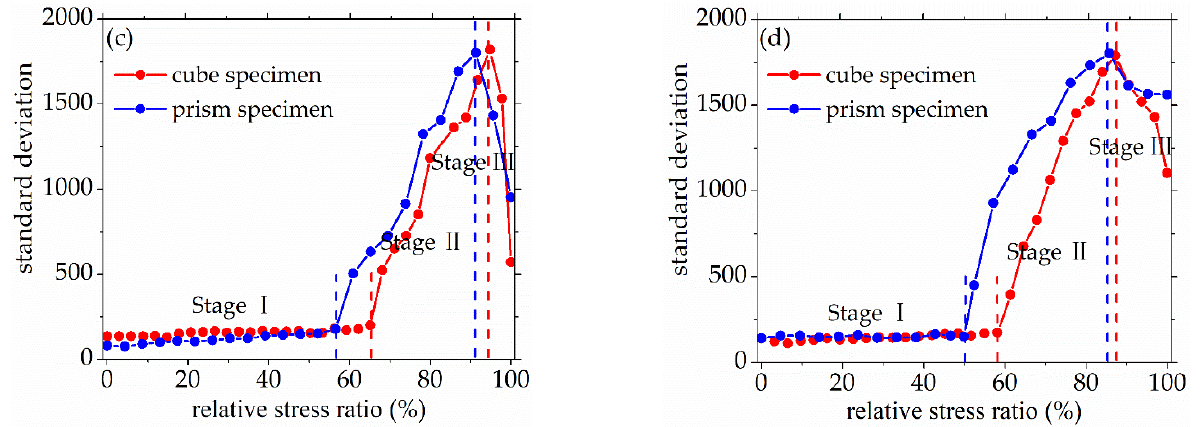
Figure 9. The standard deviations of AE elastic wave velocity for concrete with different coarse aggregate maximum size, ( a ) 9.5 mm, ( b ) 19 mm, ( c ) 26.5 mm, ( d ) 31.5 mm.